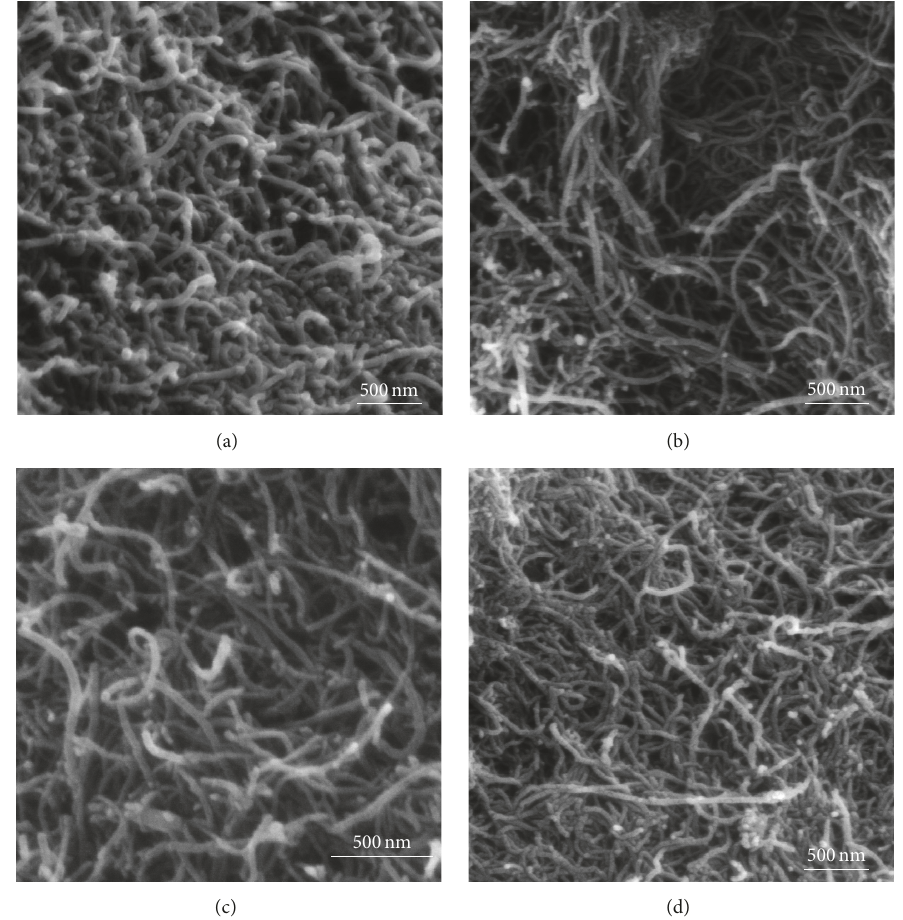
Figure 2: SEM images of (a) raw CNTs, (b) CNT-5% iron oxide, (c) CNT-10% iron oxide, and (d) CNT-20% iron